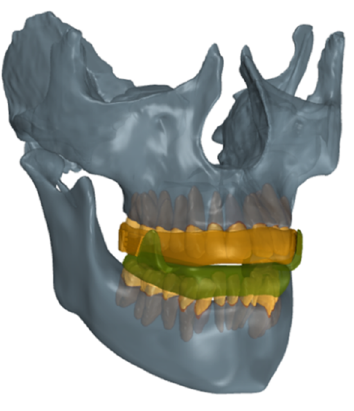
Figure 1. 3D finite element model.